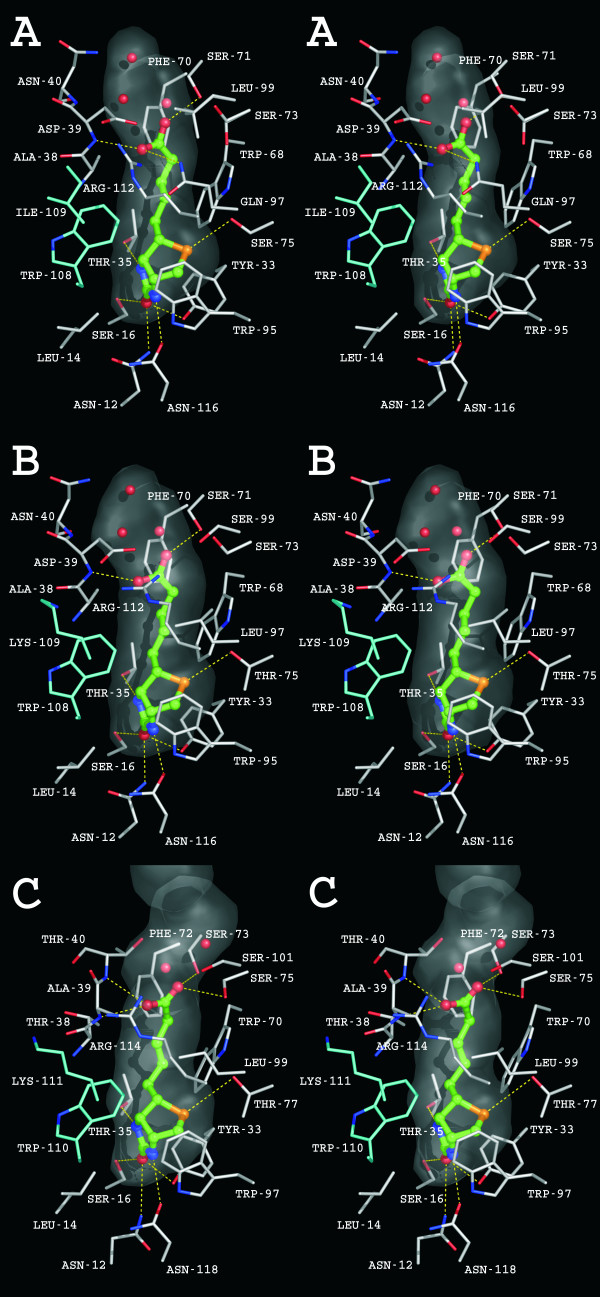
Biotin-binding sites of avidin, AVR2 and AVR4. Stereo images of the biotin-binding sites of (A) AVR2-b, (B) AVR4 [PDB:1Y52] [38] and (C) avidin [PDB:1AVD] [26] are shown. The cavities (transparent) around the bound biotin molecules of subunit A are shown. The water molecules within the cavities are shown as red spheres. Hydrogen bonds between the atoms of D-biotin and the surrounding proteins are shown with dashed lines. Carbon atoms of residues from subunit 1 are coloured white; those from a neighbouring subunit 2 are indicated in cyan: residues 108 and 109 (110 and 111 in avidin).